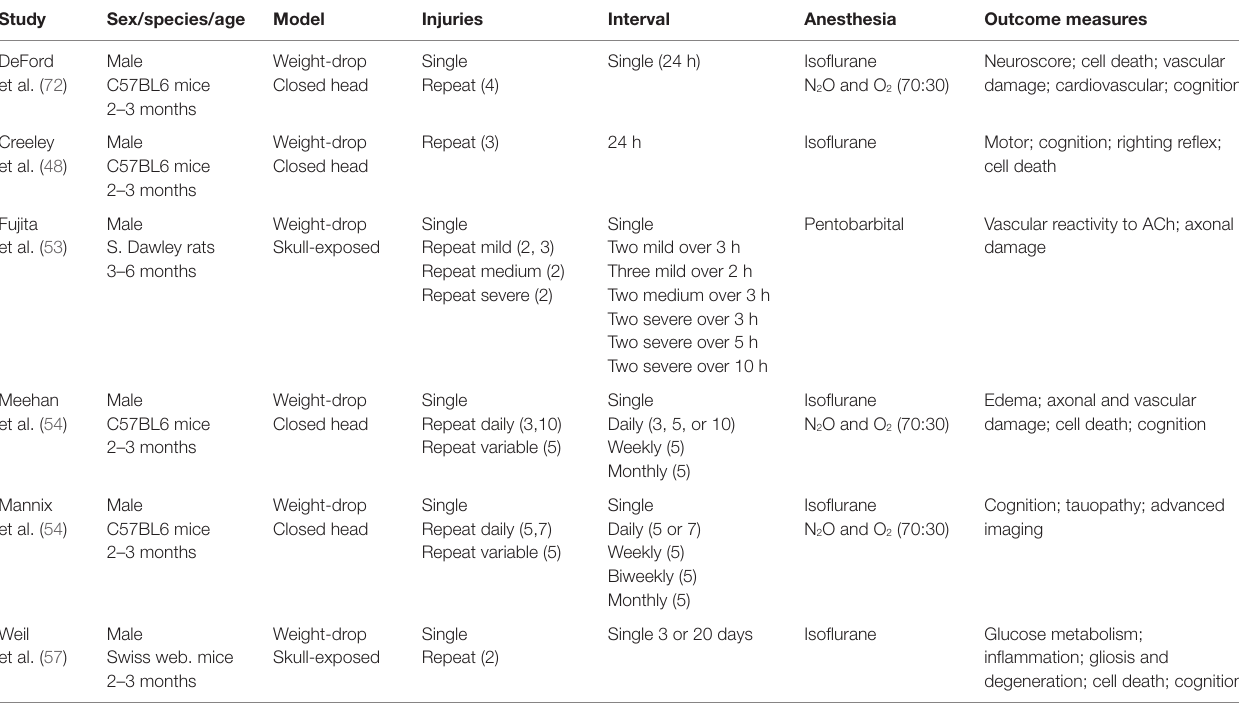
TABLe 3 | weight-drop TBi